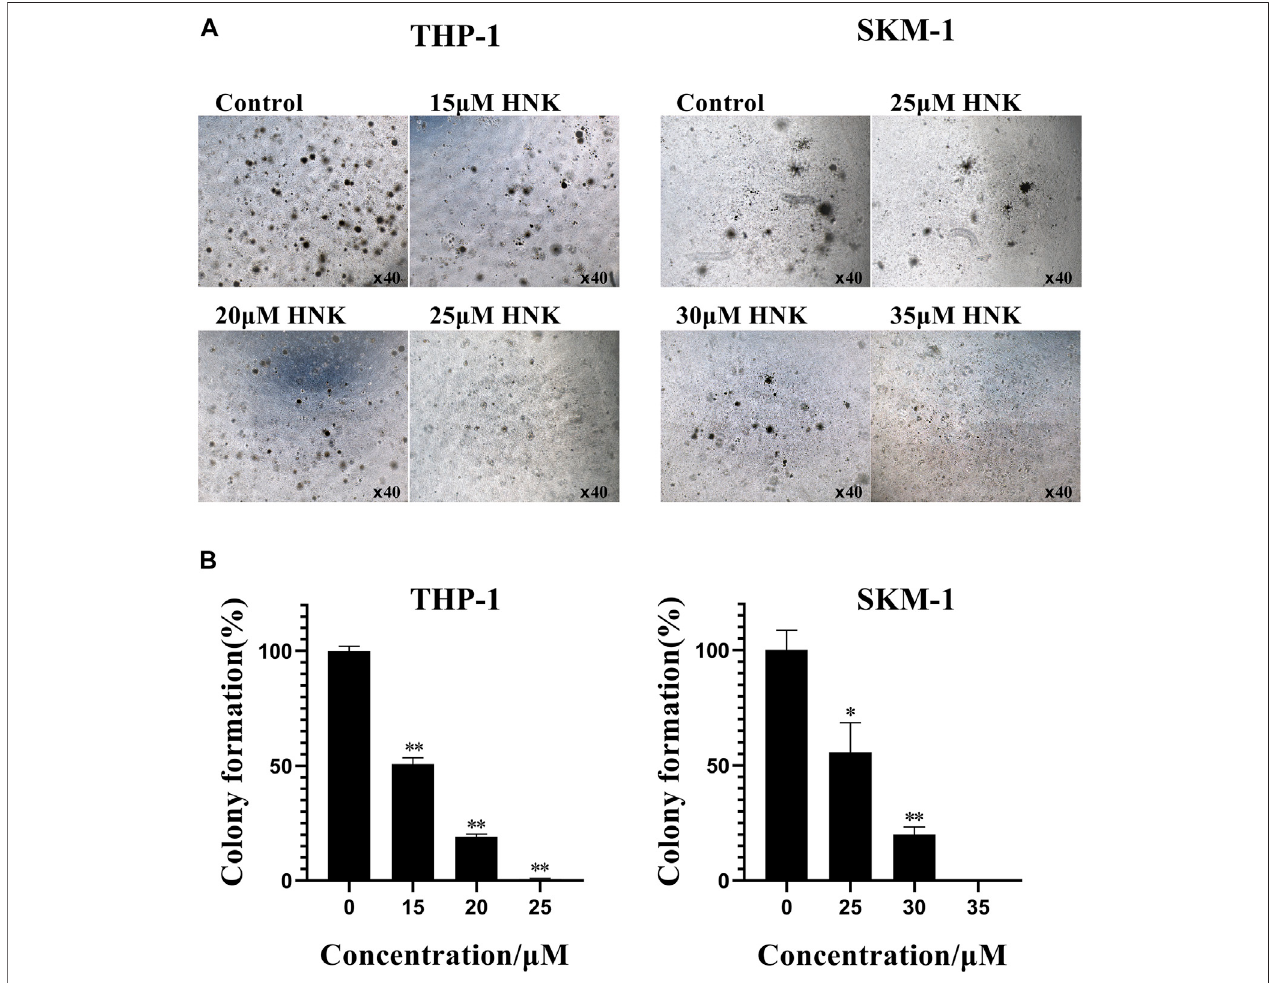
FIGURE 4 | Honokiol inhibits colony formation of THP-1 and SKM-1 cells. (A) Cell colony results of THP-1 and SKM-1 cells. Cells were incubated with different concentrationsofhonokiolfor14 daysand thenobservedunderalightmicroscope. (B) Bargraphsshowthestatisticalanalysisofcolonyformation,presented as(*, p < 0.01; **, p < 0.001). These results represent three separate